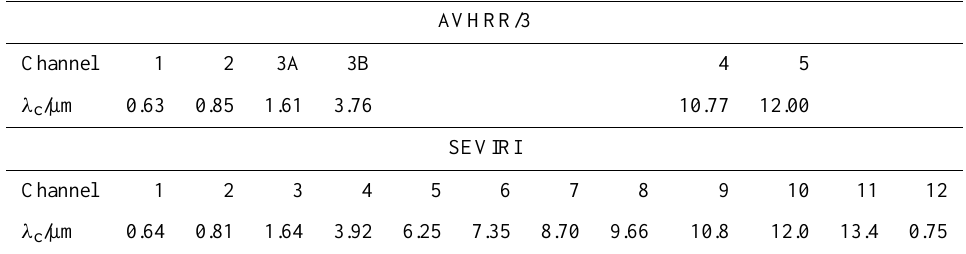
Table 2. AVHRR/3 (NOAA18) and SEVIRI channel numbers and effective channel central wavelengths λ c .